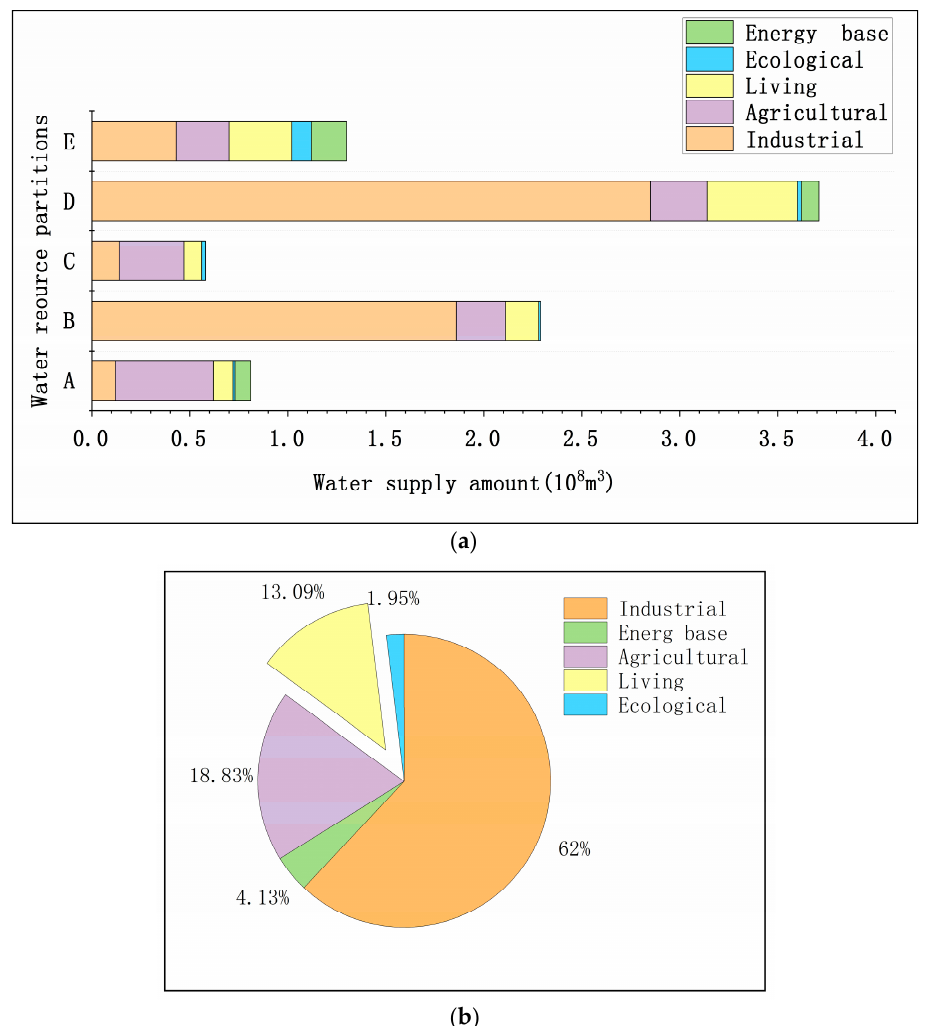
Figure 5. ( a ) Water supply analysis chart of weights distribution method (In the figure,